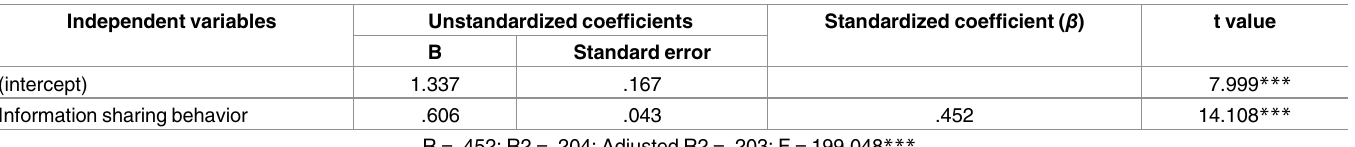
Table 8. Path analysis coefficient summaryof “information sharing behavior” to “knowledge